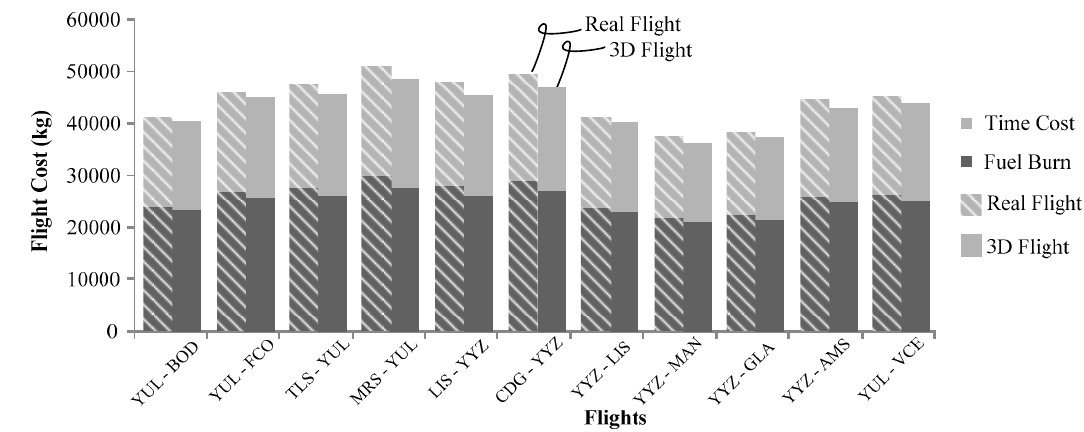
Figure 13. Real and 3D ‐ optimized time and fuel burn costs for the different flights. Table 5. Flight time comparison between real flights and the optimized 3D flights.